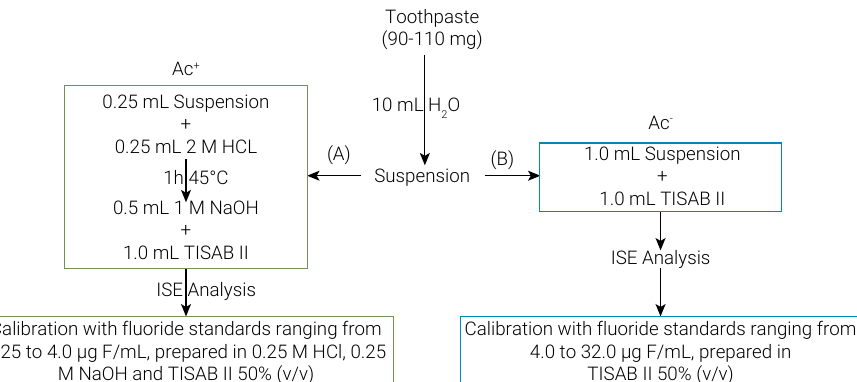
Figure 1. Toothpaste sample preparation for total fluoride determination by the conventional (A) and the simplified protocol